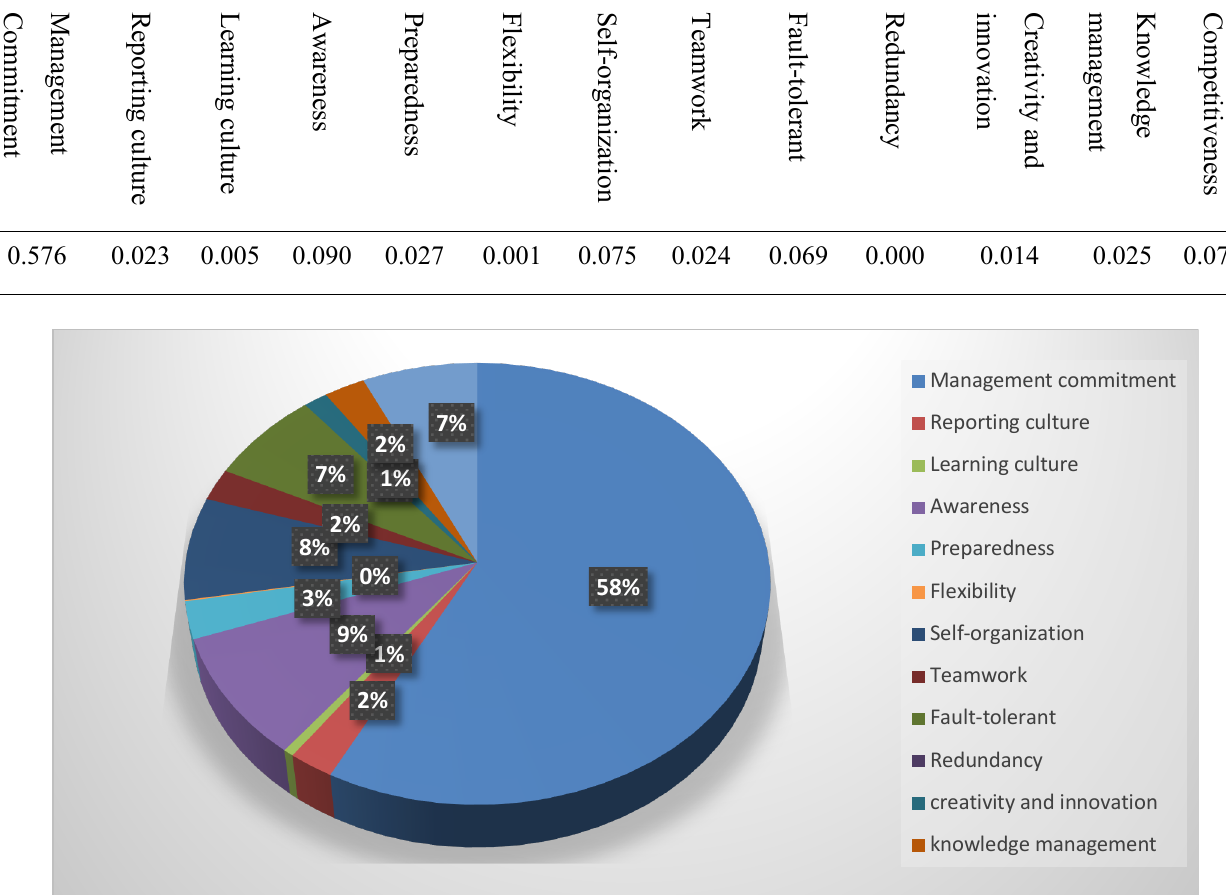
Figure 1. Weight of each resilience factor in forming performance efficiency Calculation of correlation